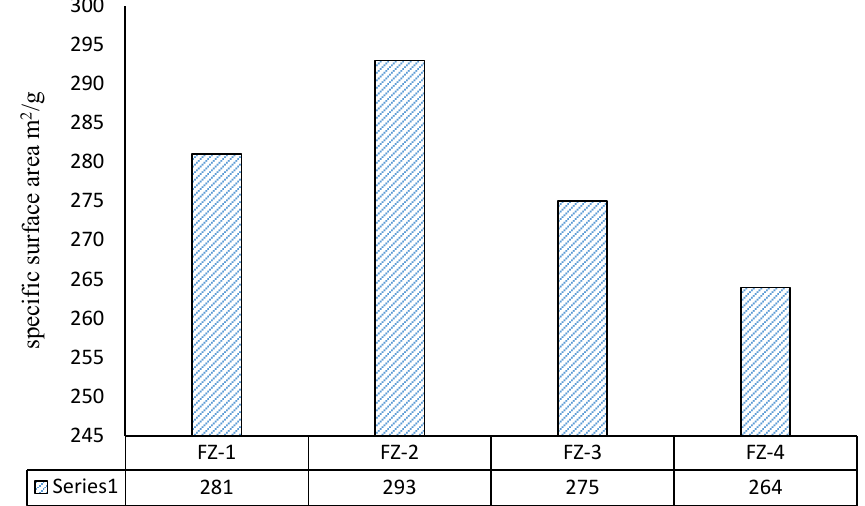
Fig. 6. BET surface area analysis of Fe-ZSM-5 samples calcined at different